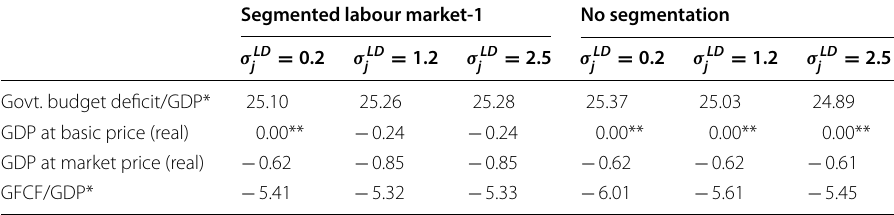
Real GDP is calculated applying GDP deflator computed from SAM * GDP at basic price (nominal); ** very small